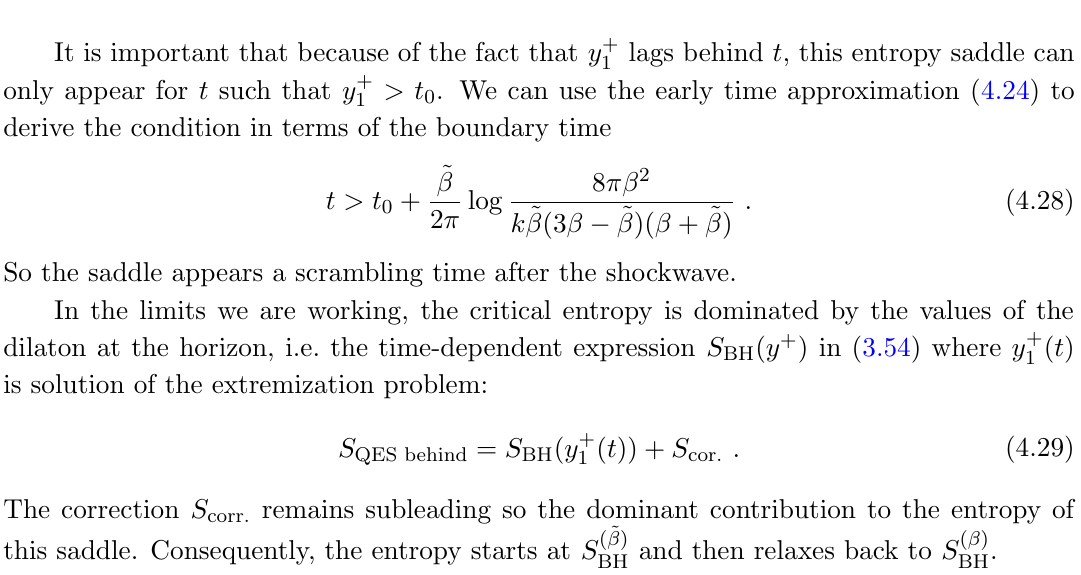
^ f ( t ) as a function of time, i.e. the scaled position of the QES relative Figure 7 . Left : a plot of ~ w (cid:0) 1 to the horizon, for some indicative values of the parameters, (cid:12) = 3, ~ (cid:12) = 1 and k = 0 : 065. Negative values correspond to points outside the horizon. Right : the scrambling time. Horizon crossing occurs at time (cid:24) 24 with the origin of the time axis set at t 0 . For the values of the parameters the ^ f ( t ) (cid:24) 0 : 5 while at long times, the plot scrambling time is (cid:24) 0 : 8. At short times (4.23), we have ~ w (cid:0) 1 manifests the saturation in (4.27) (cid:12)k= 2 (cid:25) (cid:24) 0 :